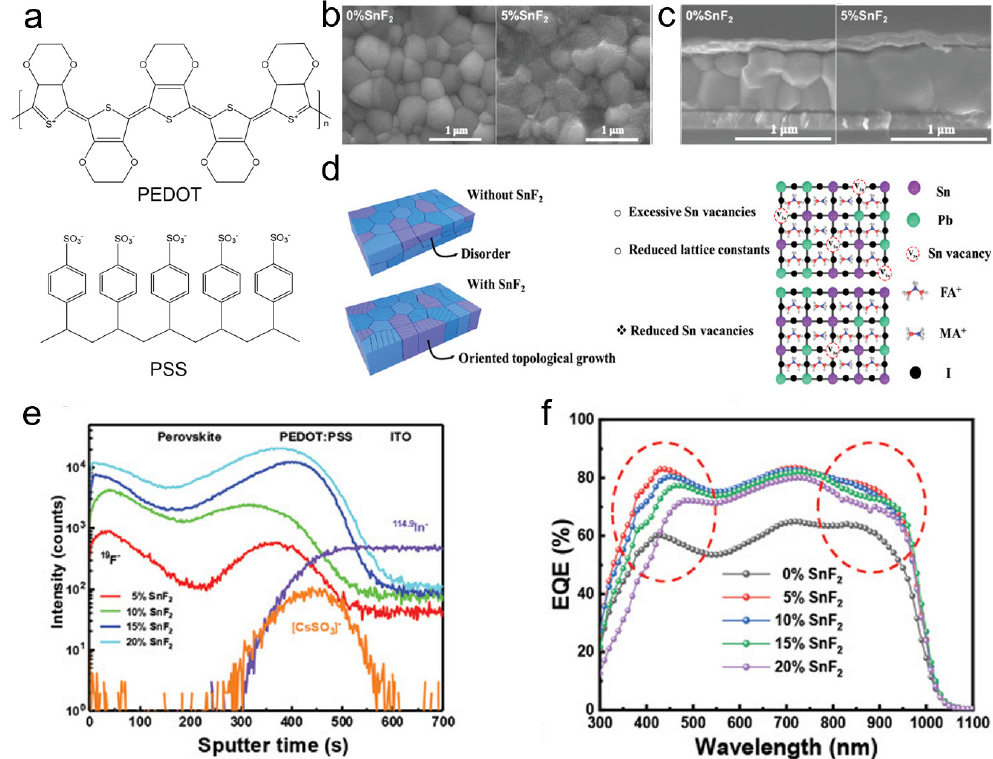
Figure 1. ( a ) The chemical structures of PEDOT:PSS. ( b ) Top-view and ( c ) cross-sectional SEM im- ages of (FASnI 3 ) 0.6 (MAPbI 3 ) 0.4 films with 0% and 5% SnF 2 . ( d ) Schematic illustration of the influence of SnF 2 on (FASnI 3 ) 0.6 (MAPbI 3 ) 0.4 perovskite growth. ( e ) ToF-SIMS depth profile of